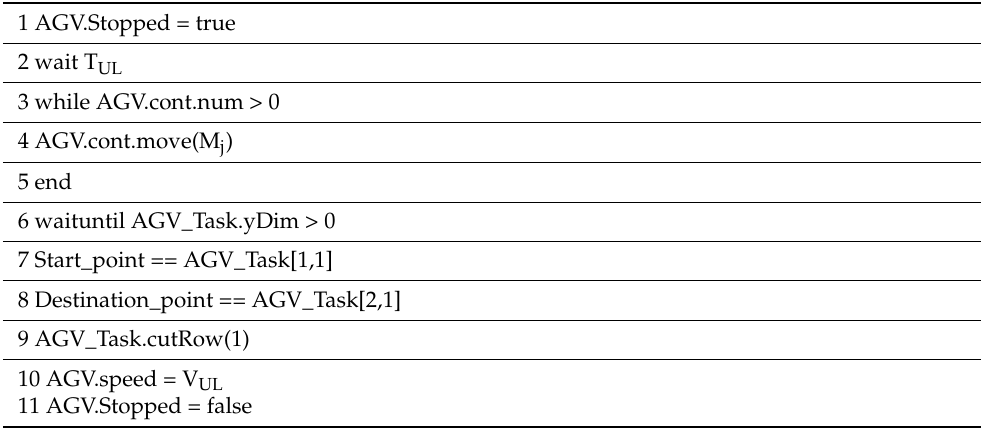
Table 5. Pseudo code of the unloading program.